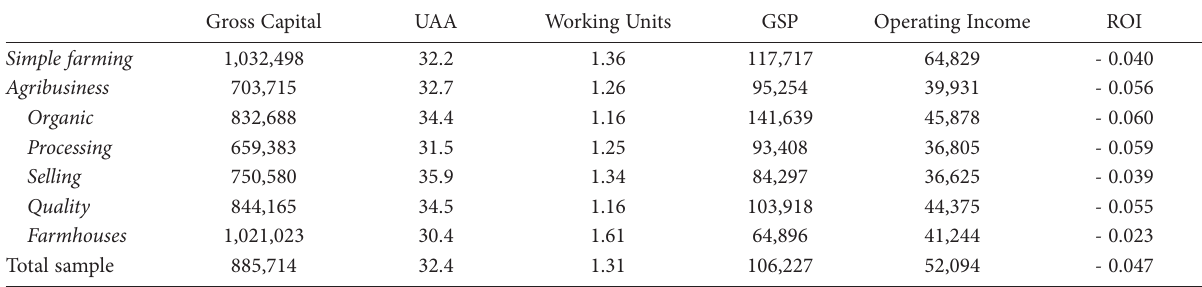
Table 2b: structural and economic features of FADN farms - average value Gross Capital